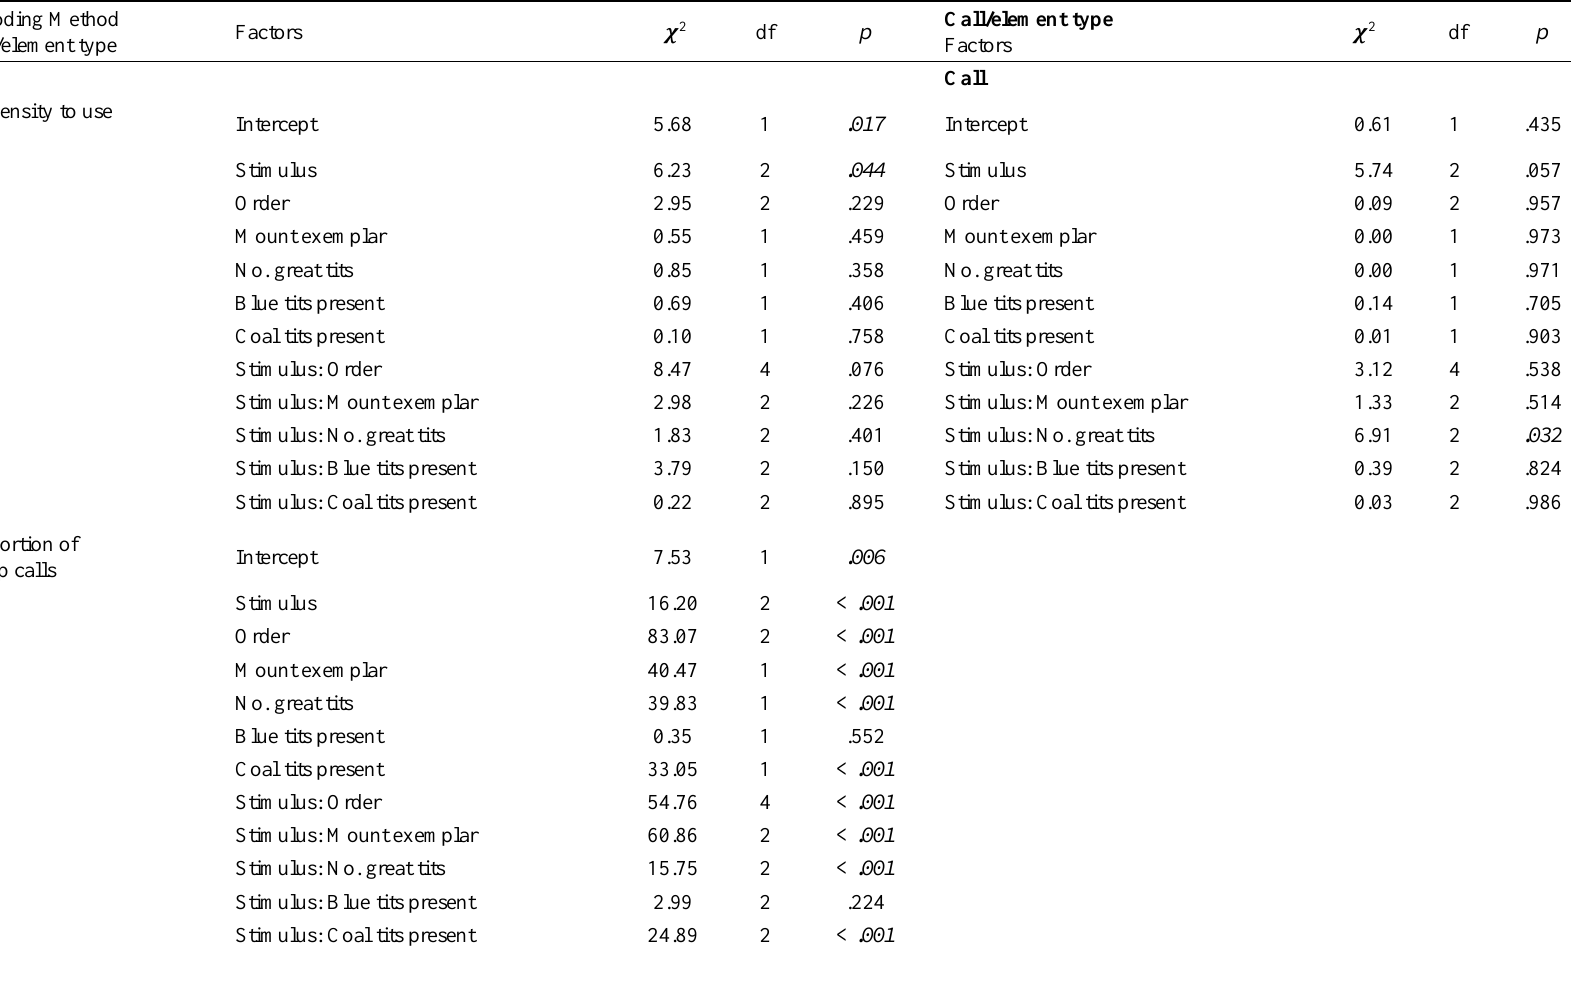
Test Results for Generalized and Linear Mixed Models Testing for Predator Type, Group Size (Conspecific and Flock Size) and Composition (Presence of Blue, Great, and Coal Tits) on Ways of Encoding Information about Predator Threat for Great Tits. Bonferroni Corrected P-Values Based on the Number of Models are